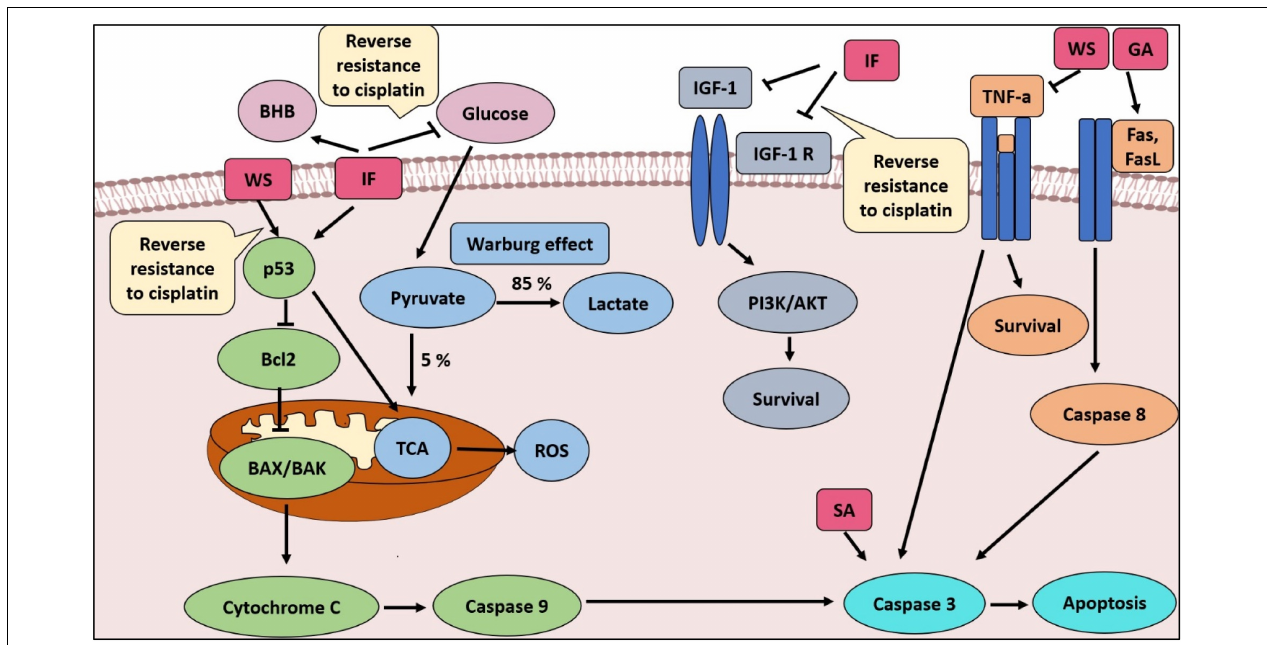
FIGURE 10 | The proposed mechanisms for WSR extract and IF combination and how they can evade cancer and sensitize resistant cells to cisplatin, when added, based on the results obtained from this study and former studies. SA, succinic acid; GA, gallic acid; ROS, reactive oxygen species; TCA, tricarboxylic acid